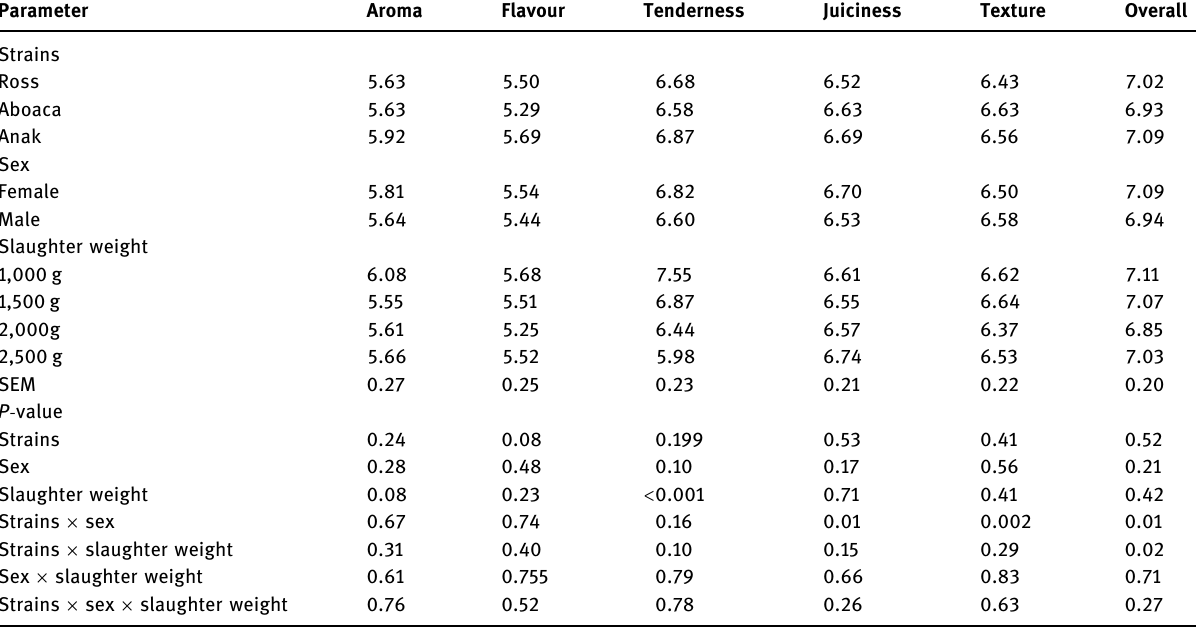
Table 7: Strain, sex and slaughter weight e ff ect on the sensory evaluation of three commercial broiler chickens Parameter Aroma Flavour Tenderness Texture Overall